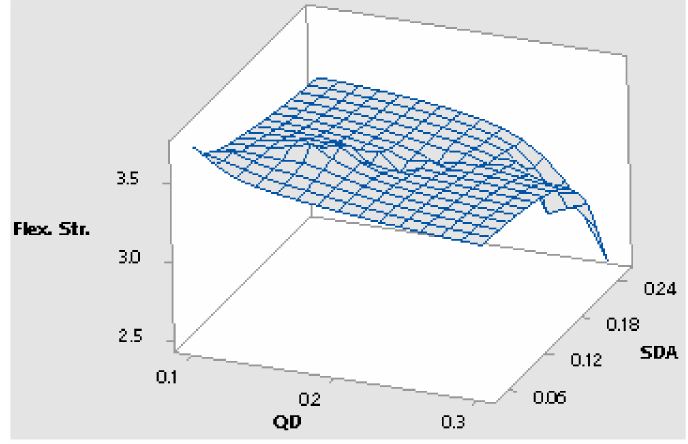
Figure 10. Three-dimensional surface plot of flexural strength response vs. admixtures.